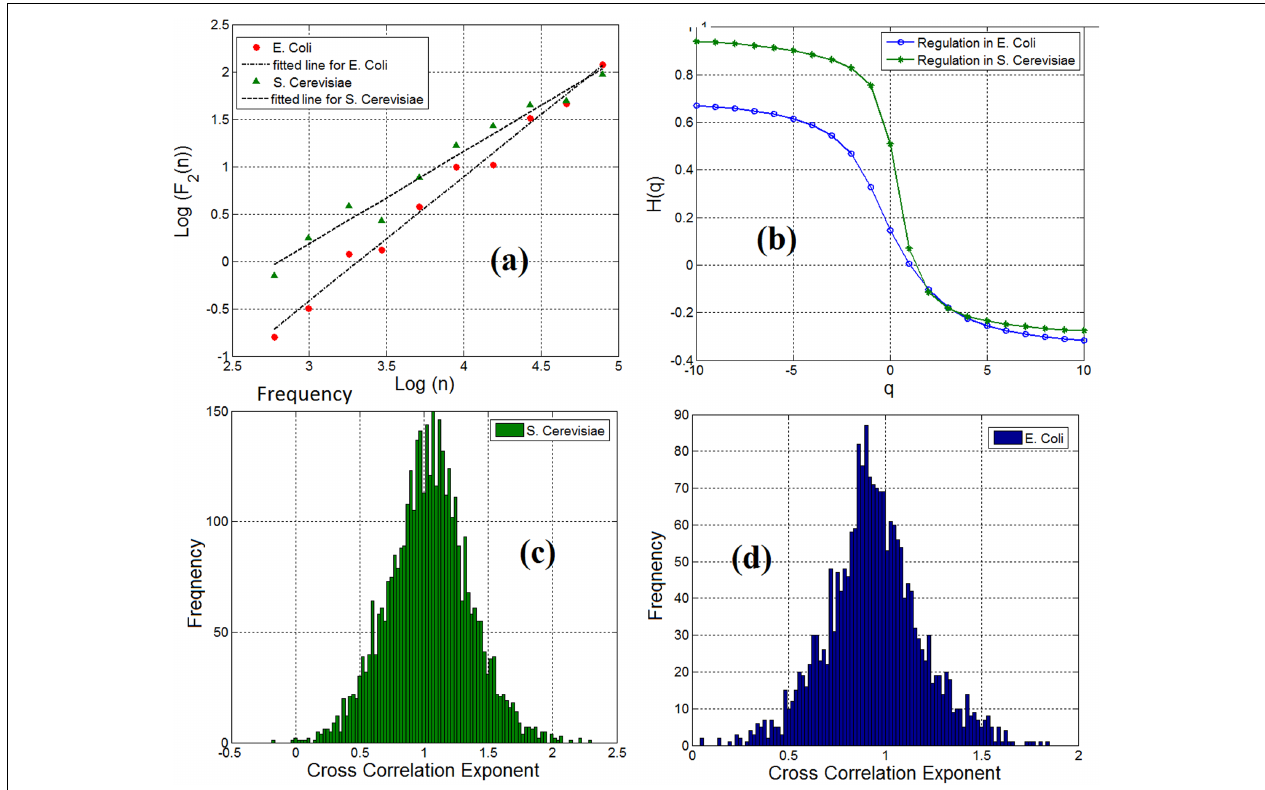
FIGURE 3 | (a) Scaling of detrended covariance function in a gene-TF link in E. coli (ihfB to ompR) and S. cerevisiae (YLR256W to YKL020C) regulatory network. (b) Generalized cross-correlation exponent of a gene-TF link in E. coli and S. cerevisiae . (c) Histogram of cross-correlation exponents of gene regulatory network links in S. cerevisiae and (d) Histogram of cross-correlation exponents of gene regulatory network links.